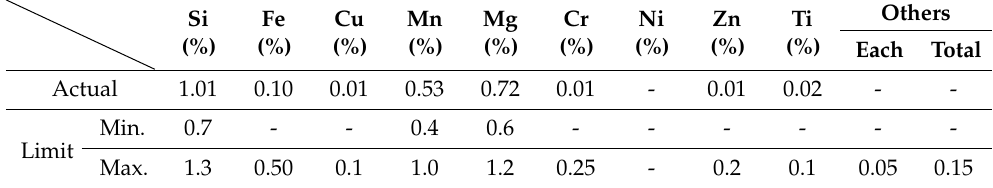
Table 7. Chemical composition of Al 6082 T6.